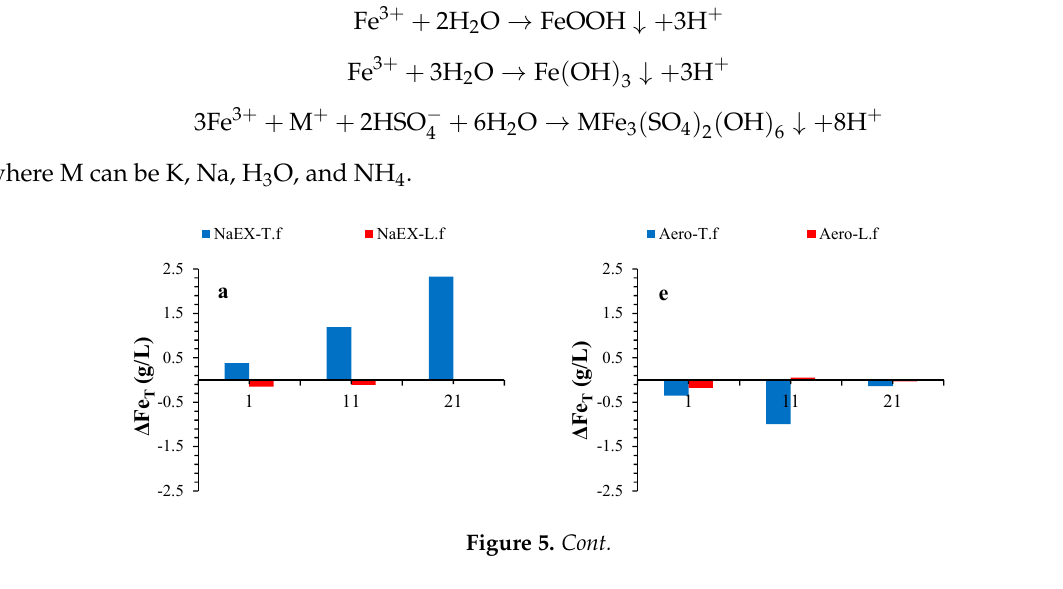
Figure 4 . Effects of various flotation reagents on bacterial population during L. ferrooxidans and T. ferrooxidans activities.